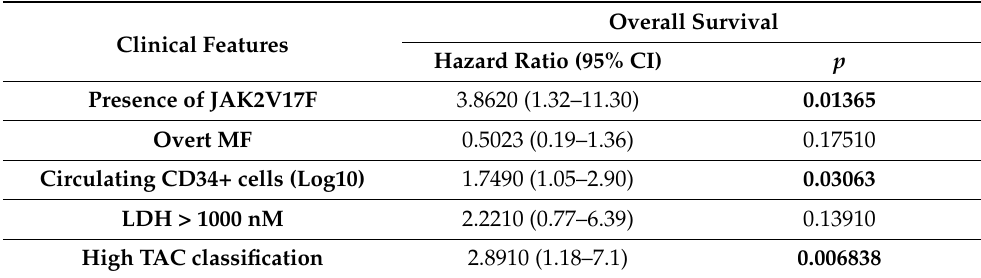
Figure 5. Kaplan–Meier analysis of OS according to TAC plasma levels. ( a ) Kaplan–Meier esti- mates OS according to TAC plasma levels. Patients’ cohort was stratified into two groups (low and high) according to the plasma levels of TAC. Blue and red curves represent patients with low or high levels of TAC respectively. ( b ) Kaplan–Meier estimates of OS according to TAC plasma levels and type of mutations. For this analysis patient cohort was stratified into four groups: CALR -mutated samples with low TAC (in violet), JAK2 -mutated samples with low TAC (in red), CALR -mutated samples with high TAC (in blue), JAK2 -mutated samples with high TAC (in yellow). ( c ) Kaplan–Meier estimates of OS according to TAC plasma levels in DIPSS lowest categories (Low and Intermediated-1). ( d ) Kaplan–Meier estimates of OS according to TAC plasma levels in DIPSS highest categories (High and Intermediated-2). Differences between two survival curves was evaluated by log-rank (Mantel–Cox) test. HR, hazard ratio computed to determine the magnitude of differences between two curves. 95% CI, 95% confidence interval. p value was computed by log-rank test. Table 2. Results of multivariate regression analysis for overall survival. The prognostic impact of High TAC levels was determined while considering other detrimental features of MF patients by means of Cox regression analysis. Significant Wald test p values ( p < 0.05) are represented in bold. 95% CI, 95% confidence